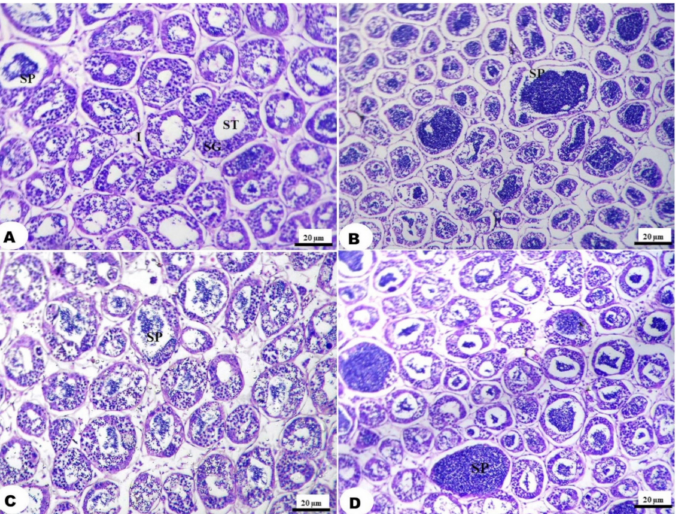
Figure 4. Testicular sections of Nile tilapia, O. niloticus , fingerlings, stained with haematoxylin and eosin stain: ( A ) Control group showing normal histology featuring seminiferous tubules (ST) lined by multilayer of spermatogonia (SG) and separated by thin strands of interstitial connective tissue contain leydig cells (I), some ST are active contain considerable amount of spermatids (SP) in its lumen. ( B ) GE 0.4 group showing normal histology with 37.45% active ST (SP). ( C ) TT 1.2 group showing normal histology with 27.95% active ST (SP). ( D ) DPPG 6 showing normal histology with 33.45% active ST (SP).